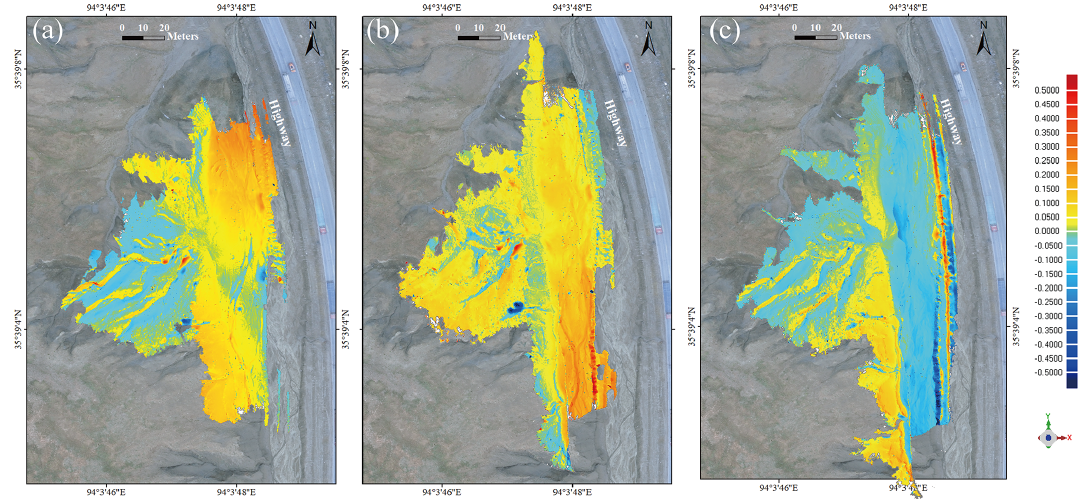
Figure 6. Deformation of slope A during the first thaw, first freeze, and second thaw: (a) first thaw, (b) first freeze, and (c) second thaw.